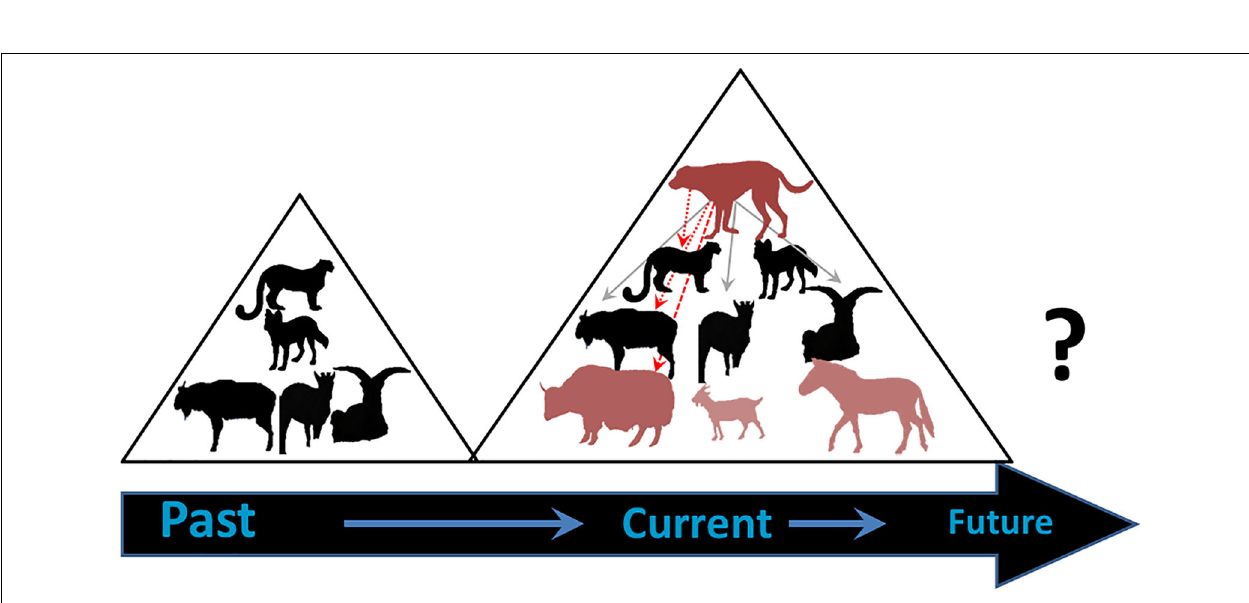
Frontiers in Ecology and Evolution |